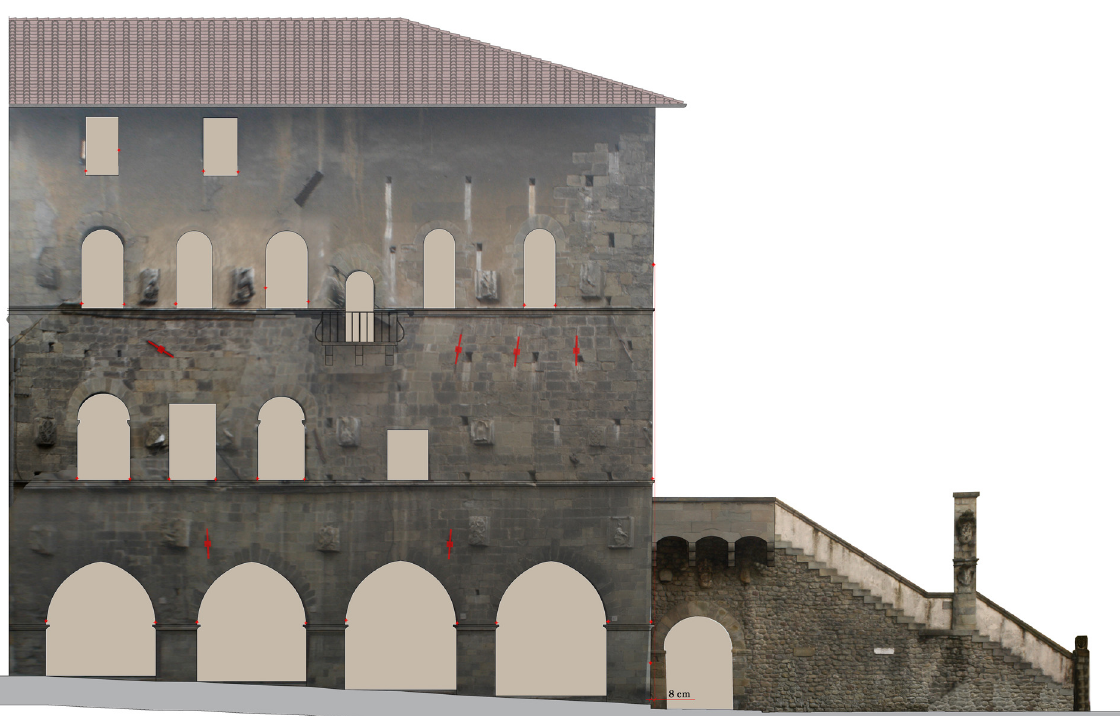
Figure 5. View of the Western façade.